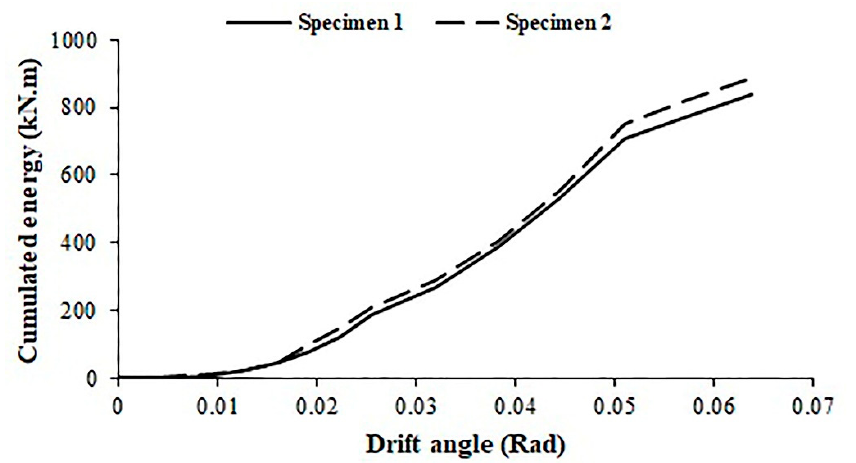
Figure 17. Cumulated energy of tested specimens.